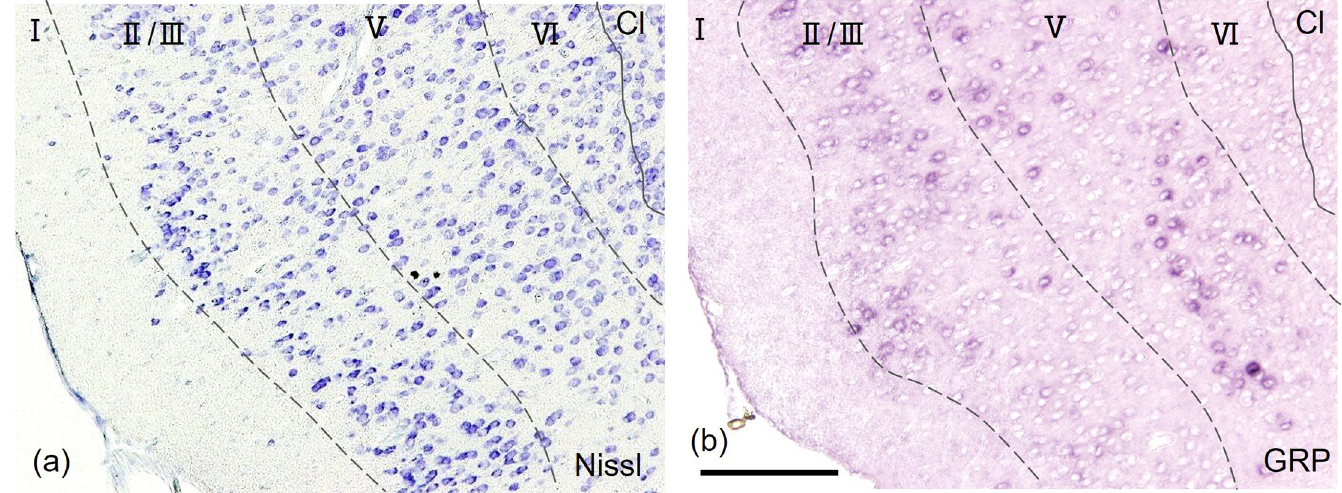
Fig 6. GRP was expressed widely in layer Ⅱ / Ⅲ and layer Ⅴ , with the highest expression in AI of the mouse insular cortex. (a), (b). High-magnification image of the squared box in Fig 5Ba4 and 5Bb4. (b). GRP was expressed widely in layer Ⅱ / Ⅲ and layer Ⅴ . (a) and (b) are adjacent sections. Scale bar: 100 μ m.